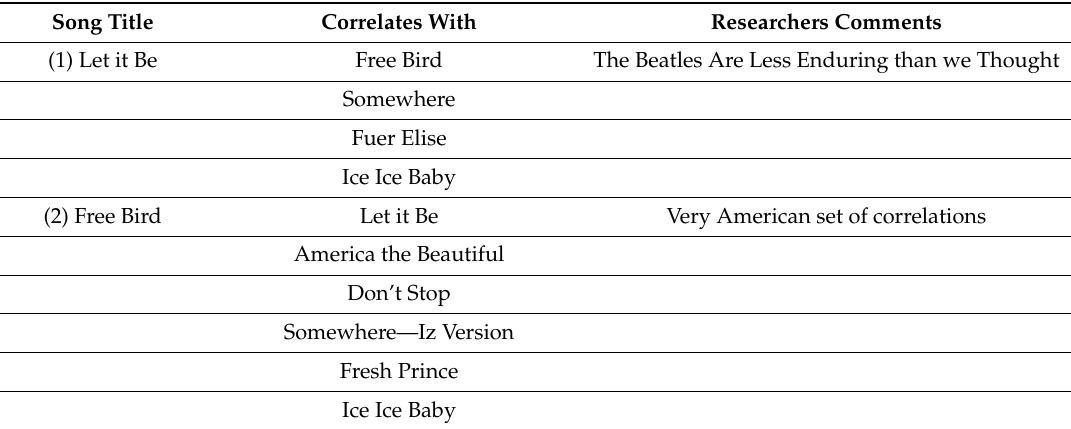
Table 2. Correlations between each of the 26 song intros (26 × 26 matrix). Correlations that were above 0.5 (one pair) are indicated in bolded 16 point type. Correlations between 0.400 and 0.499 are indicated in bolded 12 point type. Correlations between 0.300 and 0.399 are indicated in standard 10 point type.